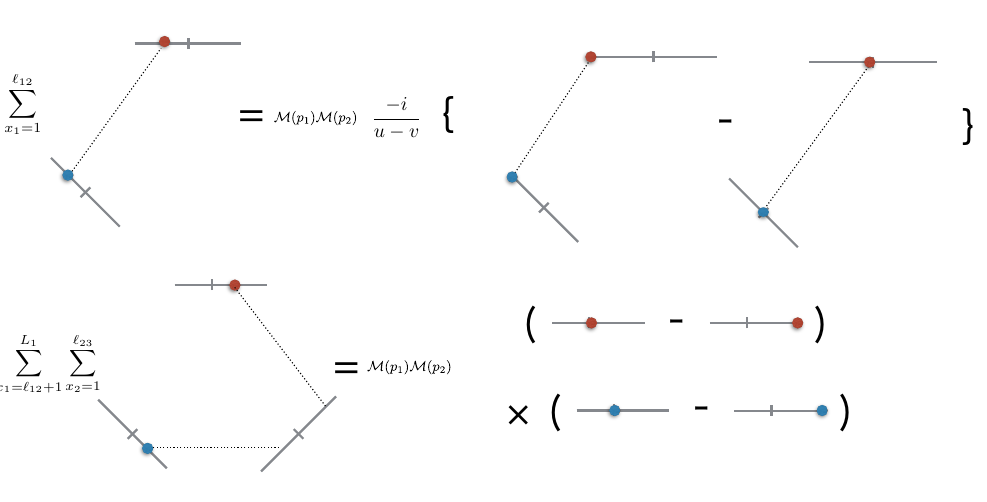
Figure 14 . The direct and the indirect